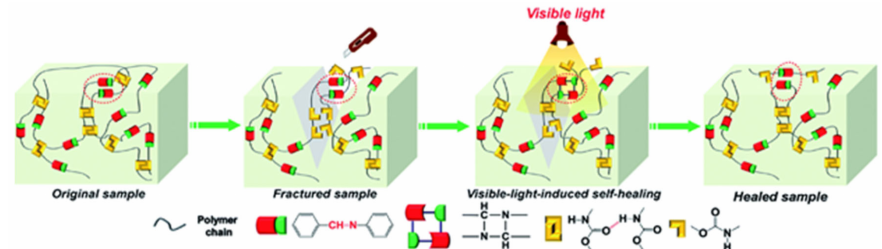
Figure 33. Diagram depicting the healing process of PU polymers. Reproduced from [185] with permission from The Royal Society of Chemistry.